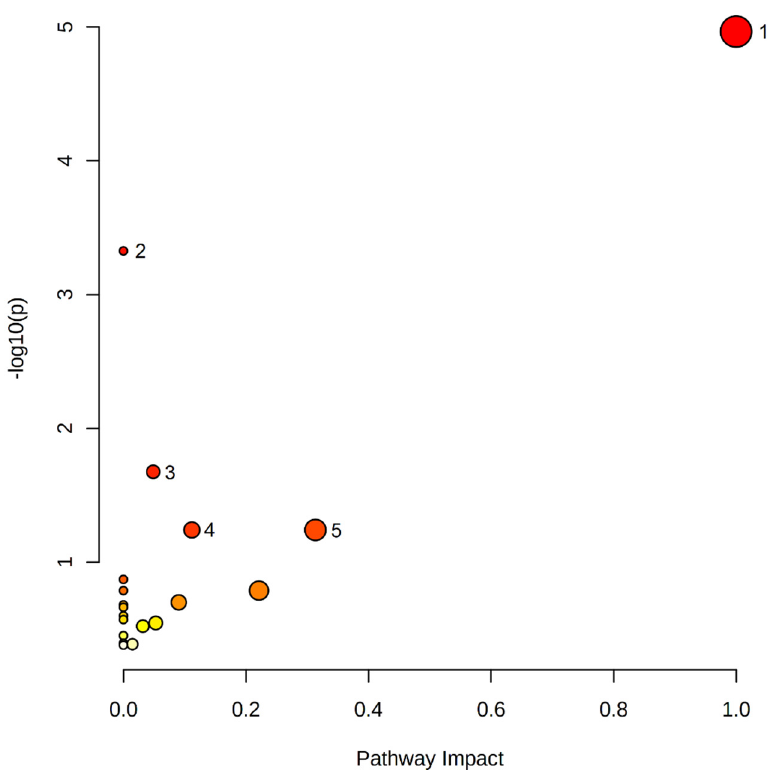
Figure 4. Intensity of 9-HpODE: ( a ) 60th minute of CE; ( b ) 120th minute of CE.